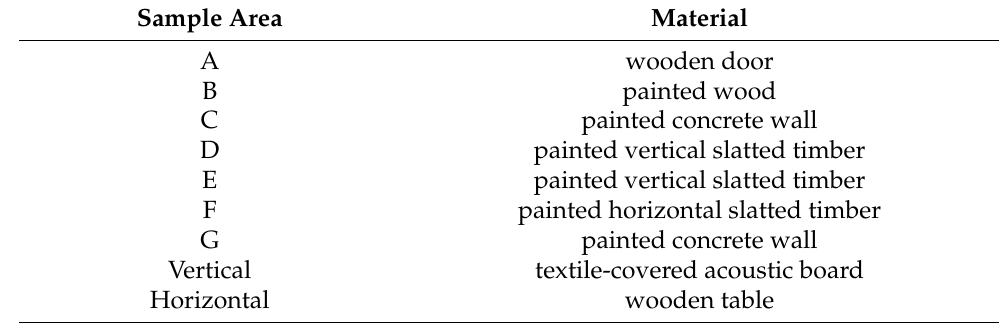
Figure 8. The intensity image from scanning station 6 shows the locations of the sample areas for luminance measurements. The green areas represent the sample areas A–G. The red area represents the vertical sample area. The yellow area represents the horizontal sample area. White points represent the 6 different scanning locations with the seventh scanning location being the observer of the image. Table 3. The sample